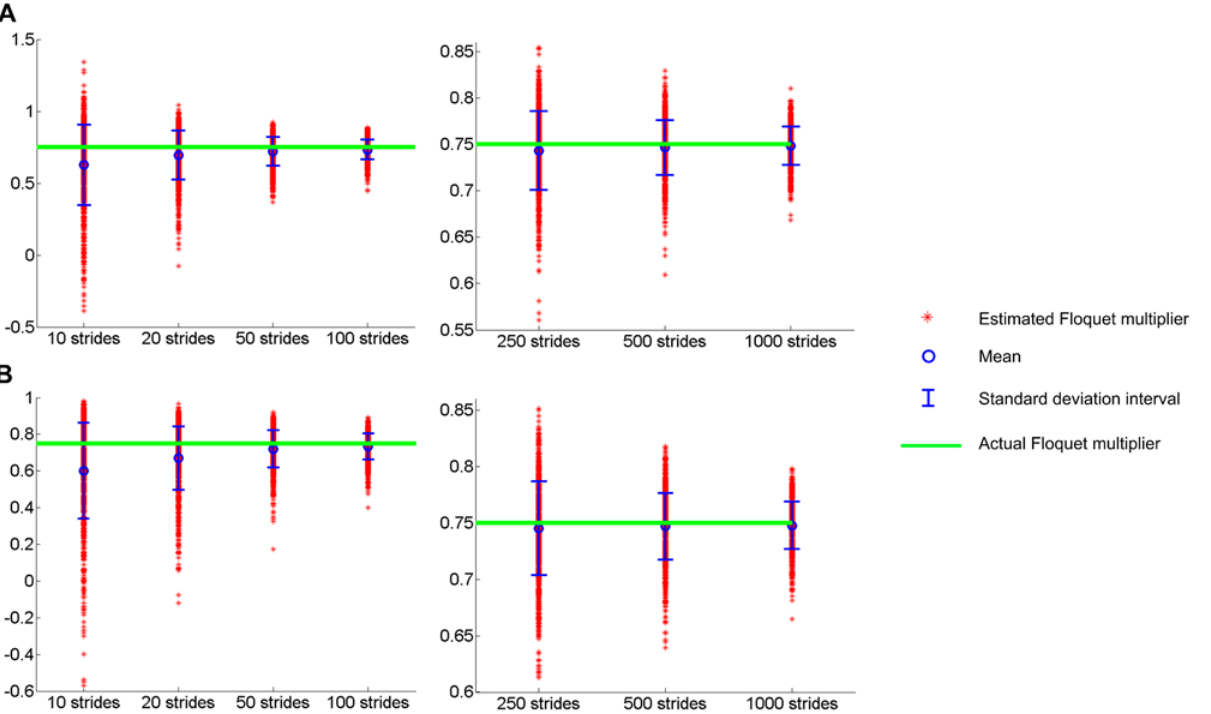
Fig 2. Estimation of a Floquet multiplier (FM) using the Yule-Walker equation and Burg ’ s Method. Time series with different length, n were generated with FM = 0.75. The FM was estimated for each time series using the Yule-Walker equation (A), and Burg ’ s method (B). In each case, the simulation was repeated 1000 times for each n . For both methods, the mean of the estimated FMs is always smaller than the actual FM though the discrepancy decreases as n increases. H 0 — the null hypothesis that the estimated orbital stability comes from a normal distribution with mean equal to the actual value — is rejected even when n = 1000. Noise drawn from normal, uniform and lognormal distributions yield similar